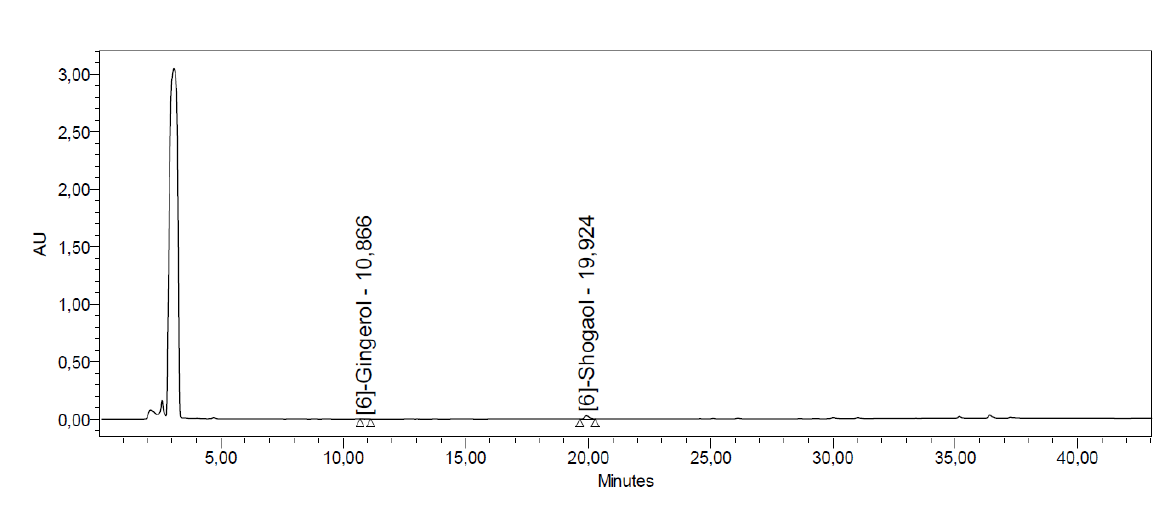
Fig. 5. The fourth food supplement„s (FS_4) chromatogram